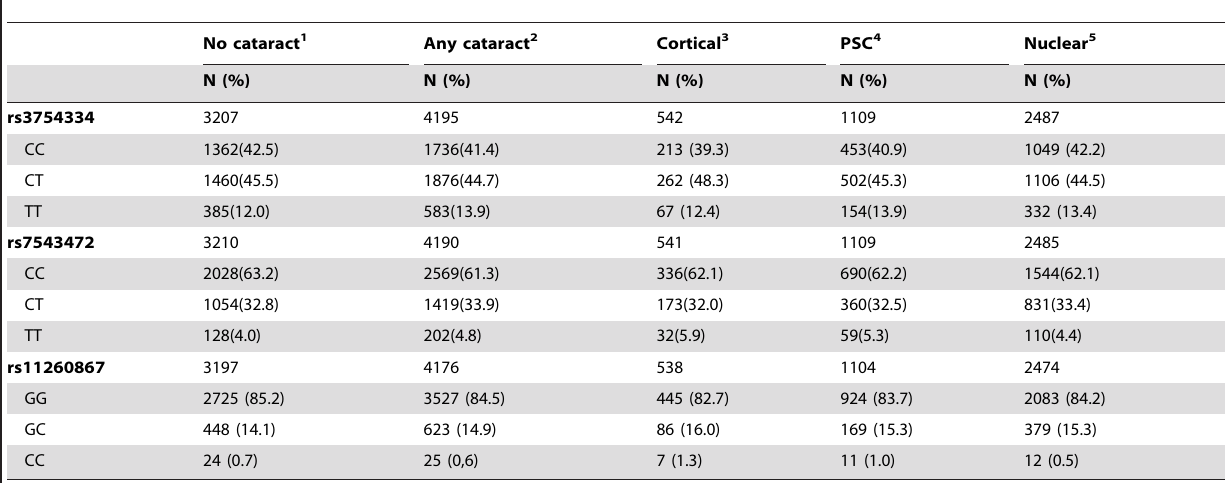
Table 2. EPHA2 genotype distribution by